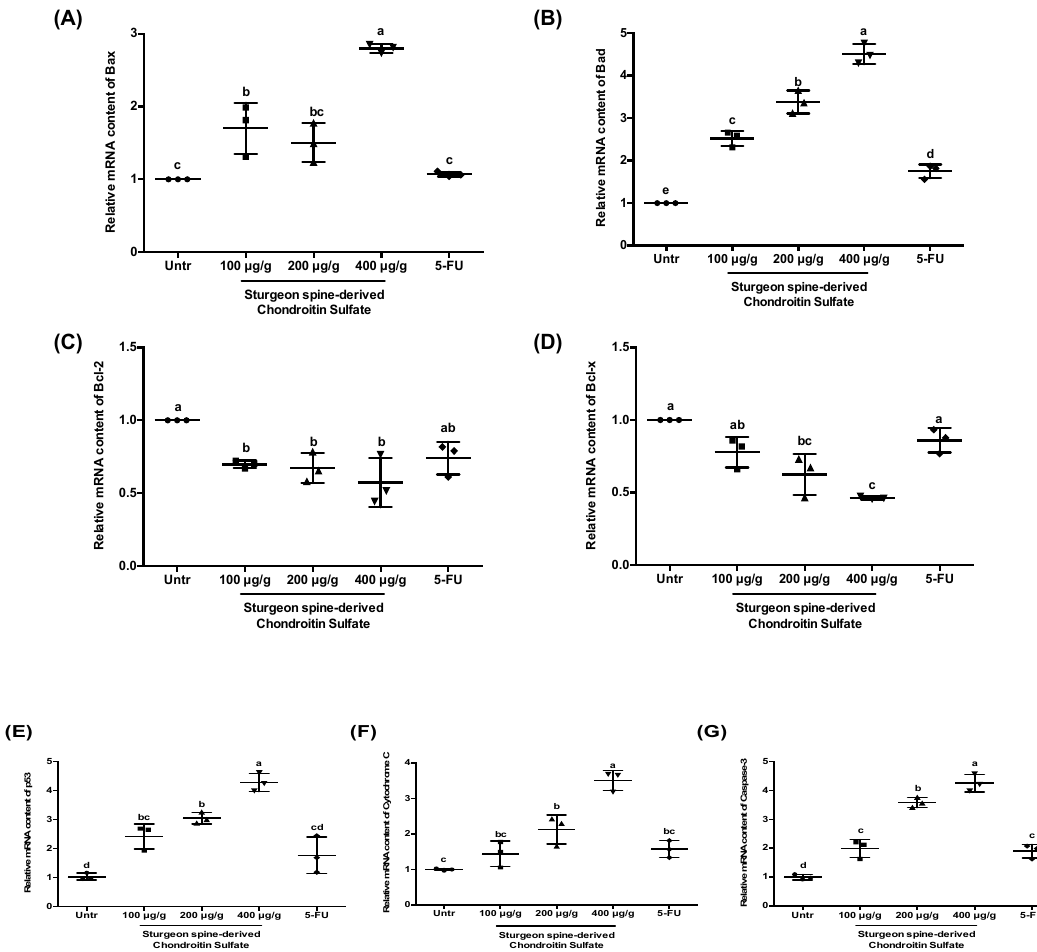
Figure 8. Effect of SCS on regulating mitochondrial pathway in HCT-116 xenograft tumor mice model. Total RNA was extracted from the xenograft tumor and the gene expression of mitochondrial apoptotic makers was measured by qPCR. ( A ) The relative mRNA content of Bax , ( B ) Bad , ( C ) Bcl-2 , ( D ) Bcl-x , ( E ) p53 , ( F ) Cytochrome c, ( G ) caspase 3 . All results are expressed as mean ± SEM ( n = 10). Different superscript letters for each column indicated significant differences ( p < 0.05) as compared to every other group.